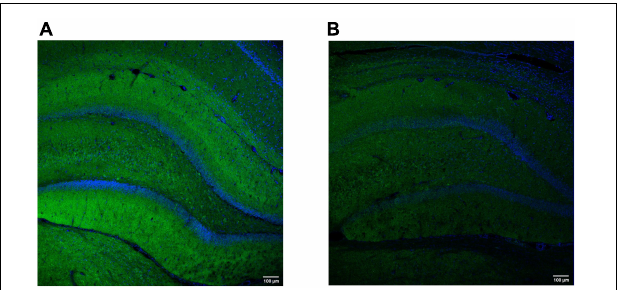
FIGURE 3 | Representative hippocampal labeling of the synaptic vesicle protein synaptotagmin-1 in a control (A) and (B) epilepsy [kainic acid rat model of temporal lobe epilepsy (Levesque and Avoli, 2013)]. Both images were obtained using the polyclonal rabbit anti-Syt1 (Abcam, Cambridge, MA; Cat#ab131551); dilution 1:100 (overnight, 4 ◦ C). The secondary antibody was donkey anti-Rabbit Alexa Fluor488-conjugated (Thermo Fisher Scientific, Oregon, United States; Cat#A-21206); dilution 1:500 (45 min, RT). DAPI was used to counterstain (blue). The images were obtained with a scanning laser microscope (Leica TCS SP5 with AOBS, Leica Microsystems IR GmbH, Germany) with a 20 × magnification and similar exposure time. Note a decrease in synaptotagmin-1 labeling in the epileptic rat (3 months after kainic acid administration), compared to the control. Images were obtained at GIGA-CRC in vivo imaging and the GIGA-Imaging platform, ULiège